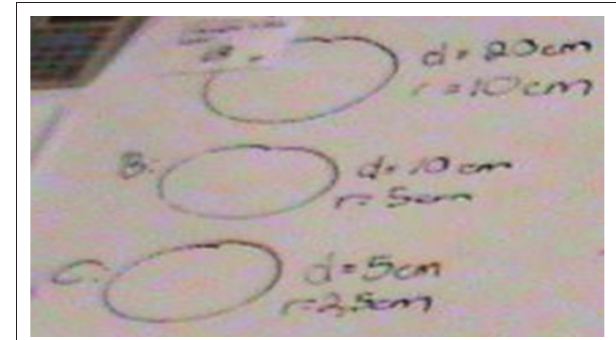
FIGURE 3: Learner C’s mathematical model for the three